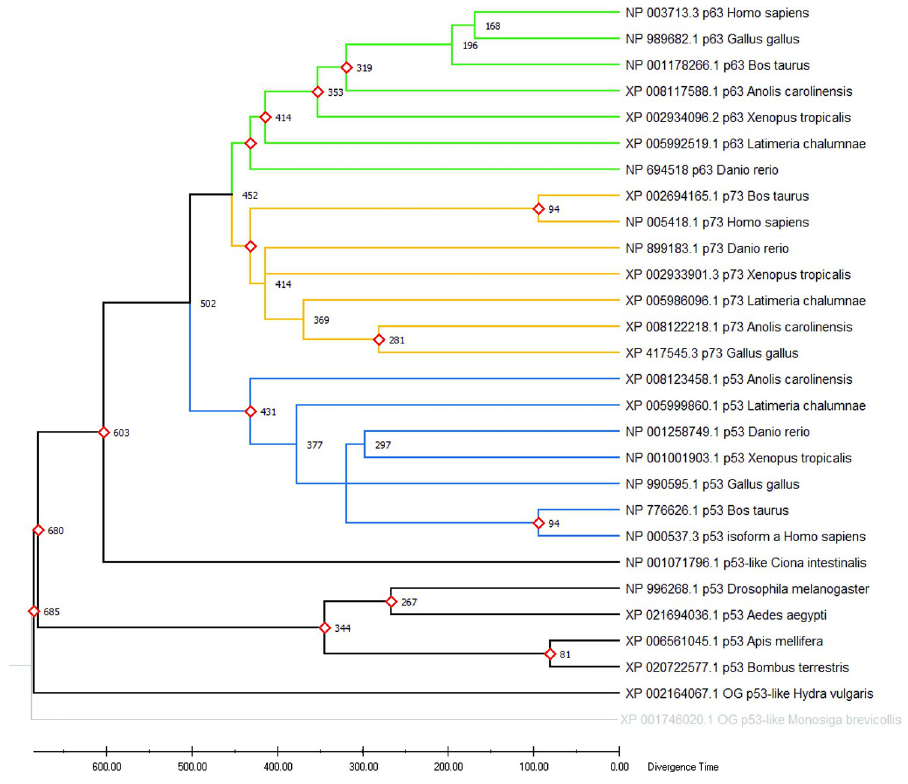
Fig 4. Time-calibrated phylogenetic tree of the P53 domain-containing proteins of metazoans. The trees were realized according to the model JTT+G [90], as calculated by ModelFinder [101] using the AIC [98]. The phylogenetic tree and the figure were realized using MEGA 11 [55]. Time calibration was performed using TimeTree [173]. The values at the nodes and the scale indicate the divergence time in million years. Green branches represent the p63 family, orange branches represent the p73 family and blue branches represent the p53 family. Gray spots on the branches indicate the appearance of the different protein domains during the evolution of the TP53 family.